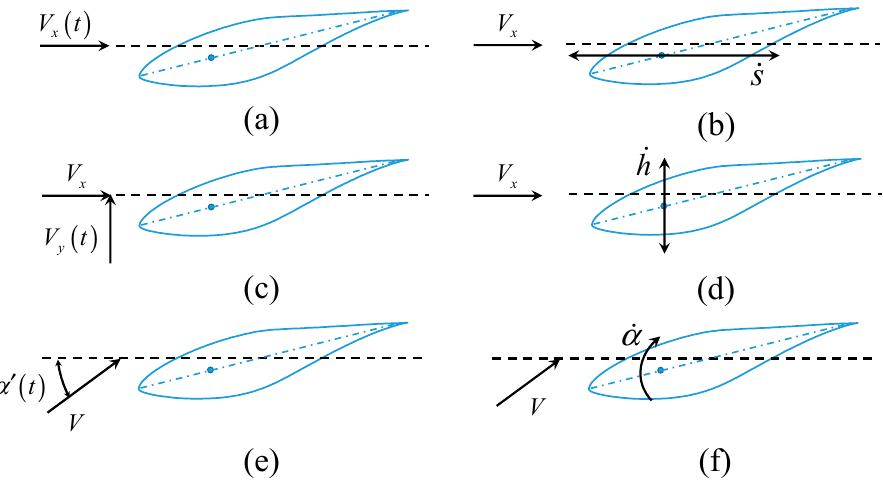
Figure 1. Schematic of different unsteady aerodynamic sources from a blade-section view. The left comes from varying flow field structures, and the right comes from the blade motion. The dashed line denotes the rotor plane. ( a ) Time-varying tangential velocity; ( b ) Fore-aft motion; ( c ) Time-varying normal velocity; ( d ) Plunge motion; ( e ) Oscillating freestream; ( f ) Pitch oscillation.